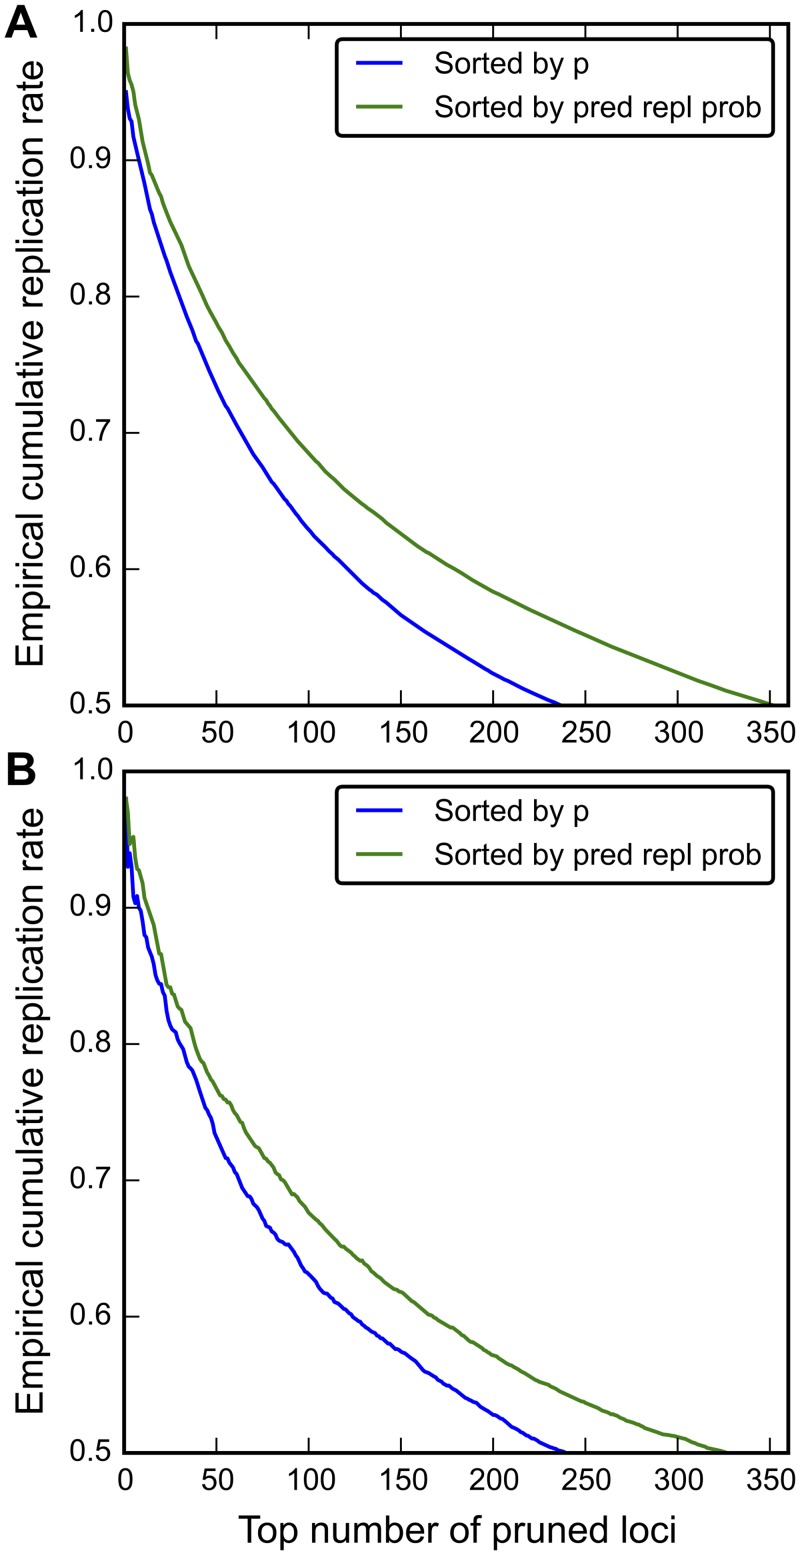
CM3 improves power of identifying gene loci.The average empirical cumulative replication rates (y axis) are plotted against the number of SNPs replicating at that rate > 0.5 (x axis), after removing MHC region SNPs and pruning at LD r2 < 0.1. A.) The full PGC sample was used to estimate predicted replication probability (pred repl prob). For each iteration, 26 PGC schizophrenia sub-studies were randomly assigned to the discovery sample, and the rest to the replication sample (split half). The average values over 500 iterations are shown, and B.) Half of the PGC sample (26 sub-studies) was used to estimate the predicted replication probability. For each iteration, 26 PGC schizophrenia sub-studies were randomly assigned to the discovery sample, and the rest to the replication sample (split half). Then, the predicted replication probability was estimated by applying the CM3 method on the discovery sample with 50 iterations. The p values (computed by meta-analysis) of the discovery sample and the predicted replication probabilities (computed by CM3) were used to sort SNPs in replication sample, consist of rest of the sub-studies. The average replication rates across 50 iterations were shown. Colors indicate different sorting criteria (green: sorted by prediction replication probability and blue sorted by nominal p values).